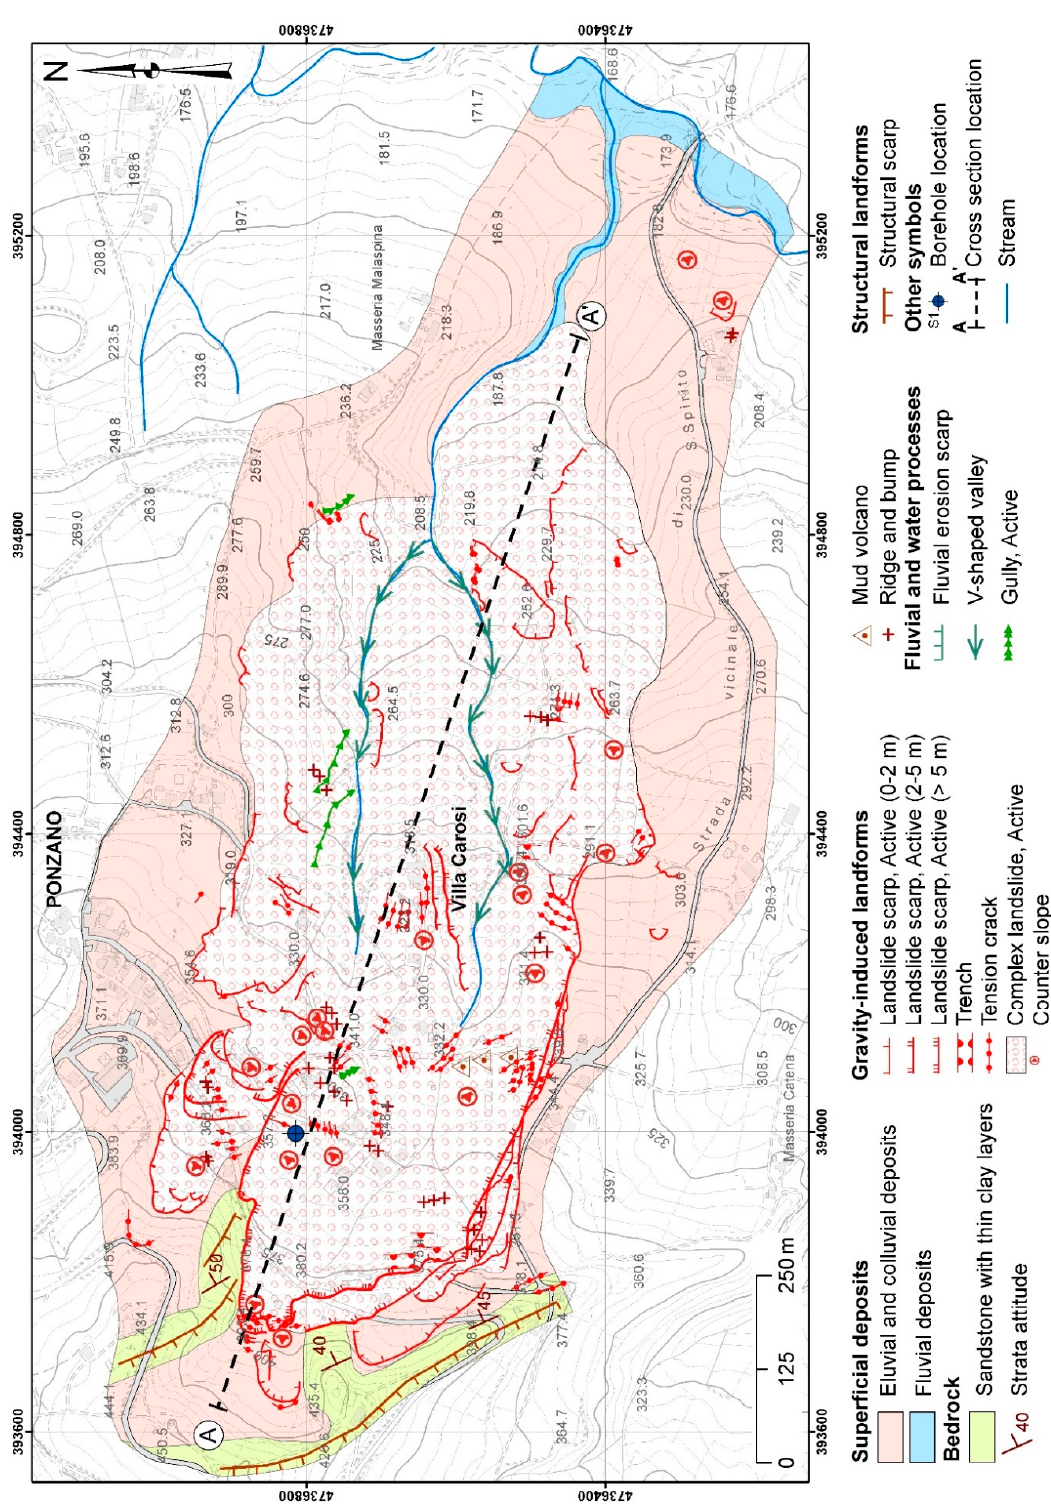
Figure 8. Geological and geomorphological map of the Ponzano area.